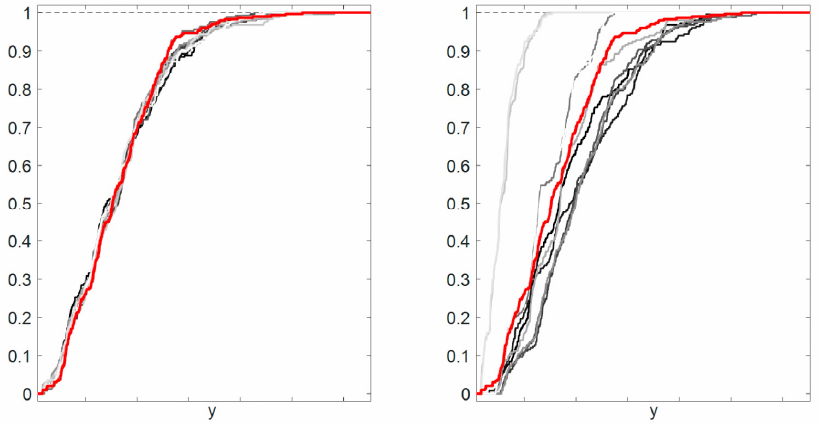
Figure 6. Illustrative CDF examples of a model with Y output. Red lines indicate unconditional CDFs, F y ( y ) , and gray lines indicate conditional CDF, F y | xi ( y )